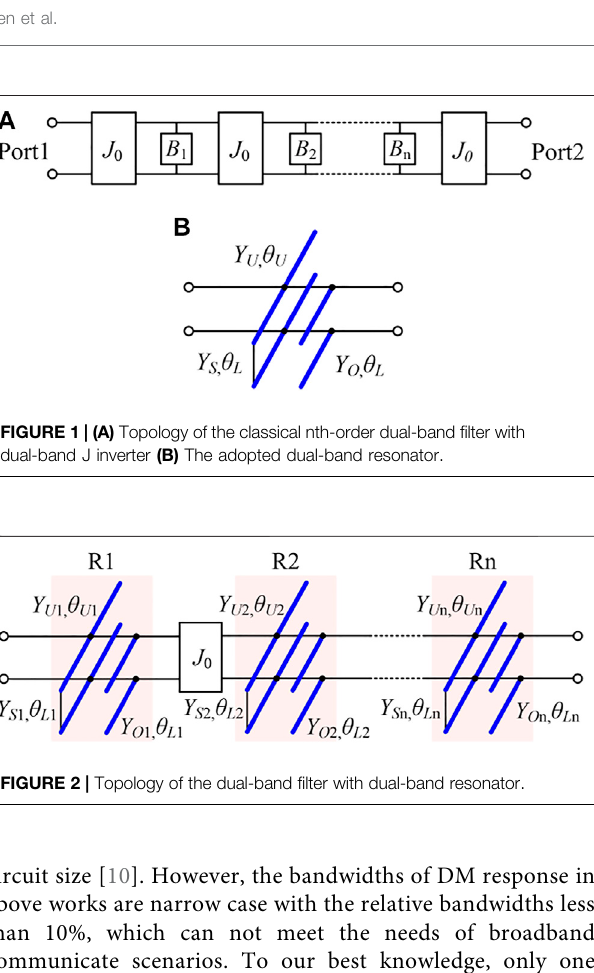
FIGURE 2 | Topology of the dual-band fi lter with dual-band resonator.